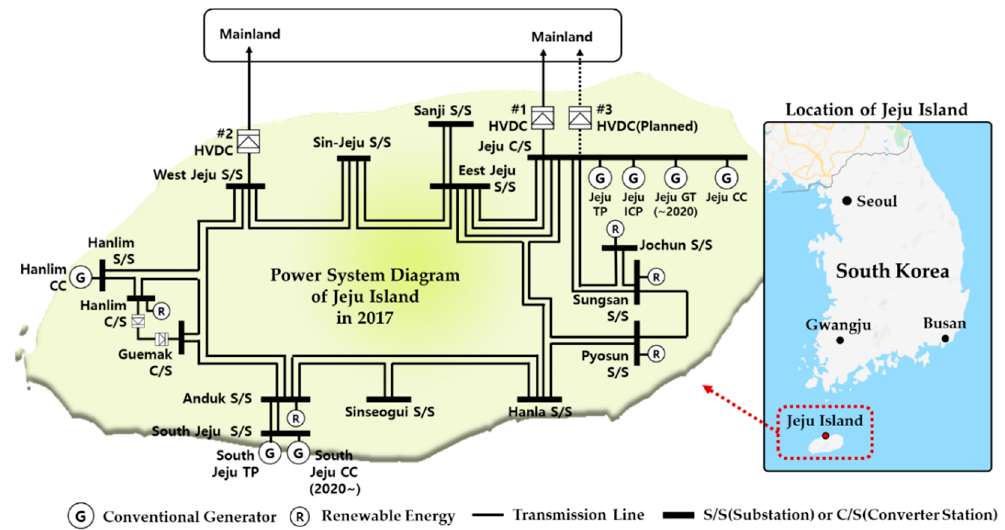
Figure 1. Power system diagram of Jeju Island in 2017 and the location of Jeju Island in South Korea.